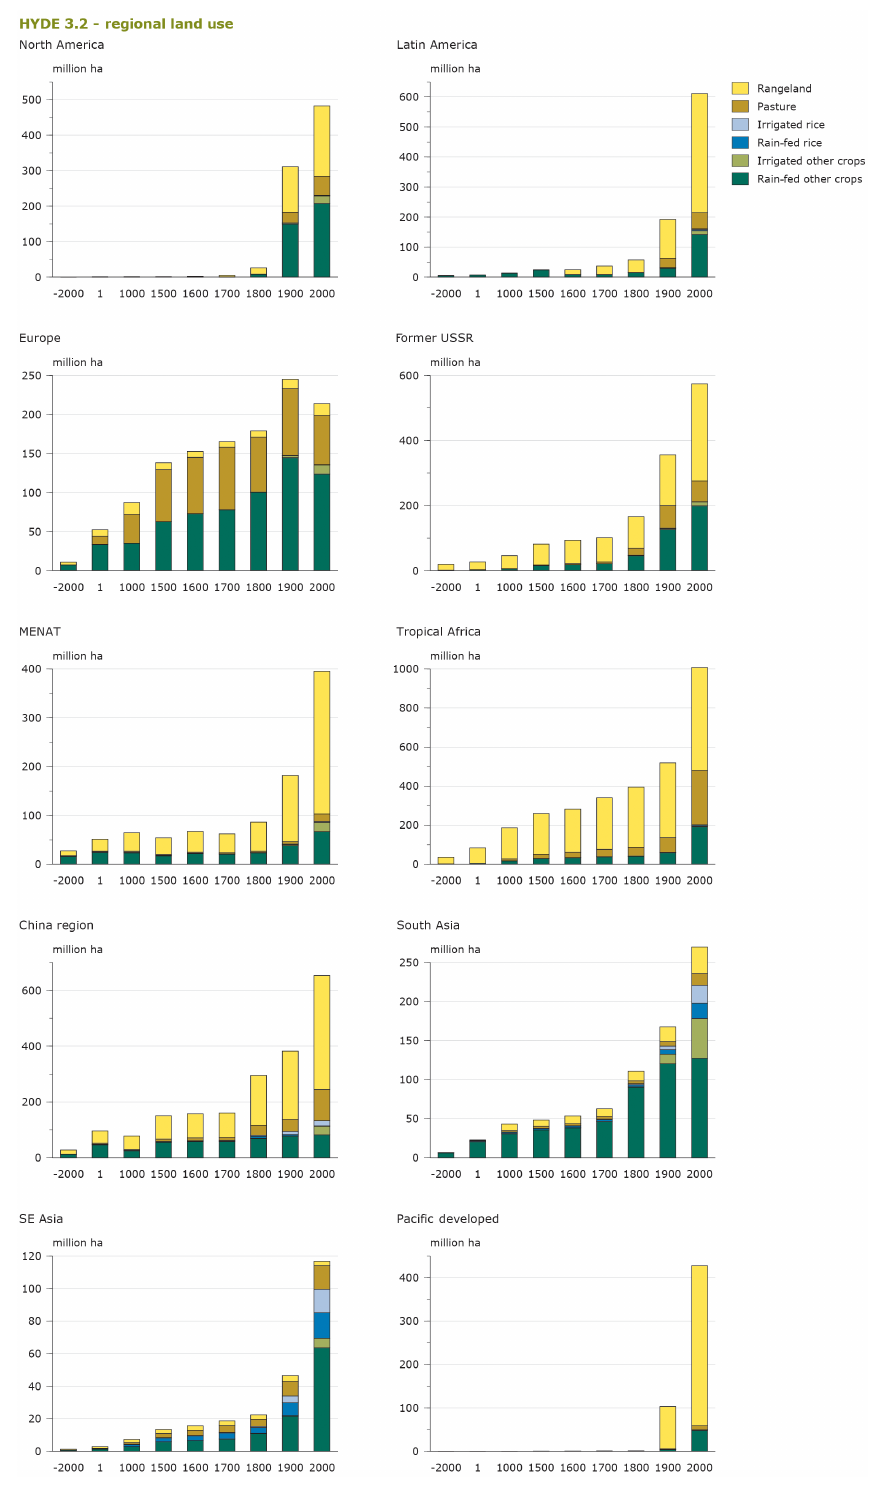
Figure 7. Historical land use estimates by region, for irrigated and rain-fed rice and other crops, rangeland and pasture. Please note the rangeland and pasture distinction is purely an indication of the intensity of use, not of the land use conversions involved (see Sect. 3.2.2 “Grazing